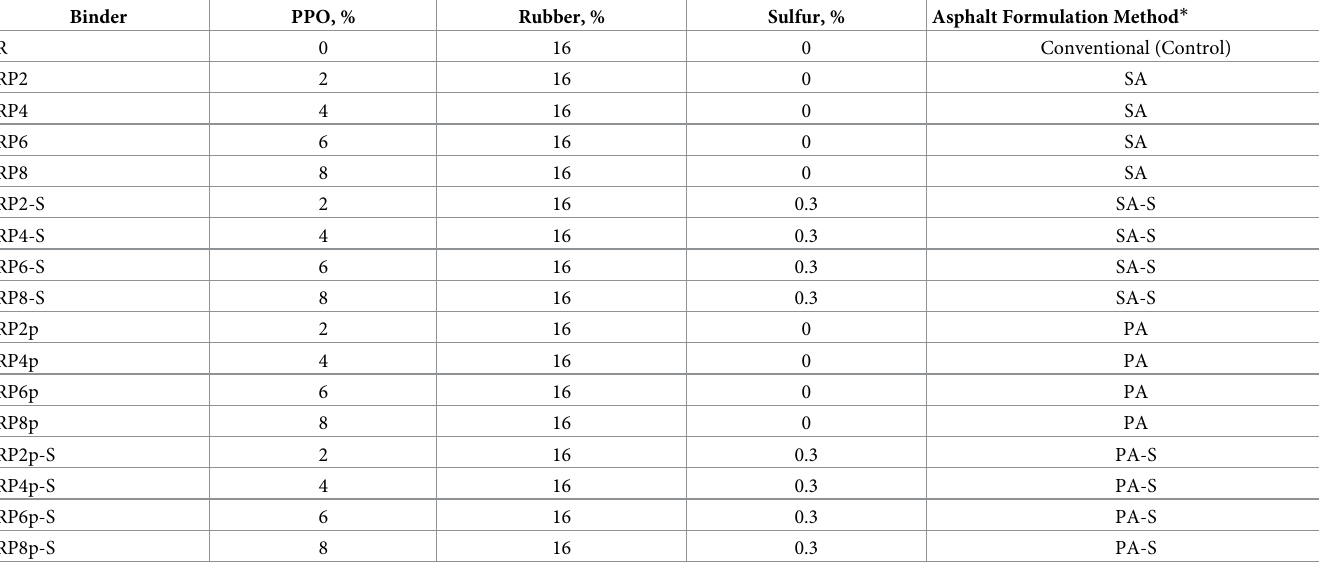
* SA: Sequential addition of rubber and oil; SAS: Sequential addition of rubber and oil along with sulfur; PA: Pre-swelling with heat-treatment; PAS: Pre-swelling with heat-treatment along with